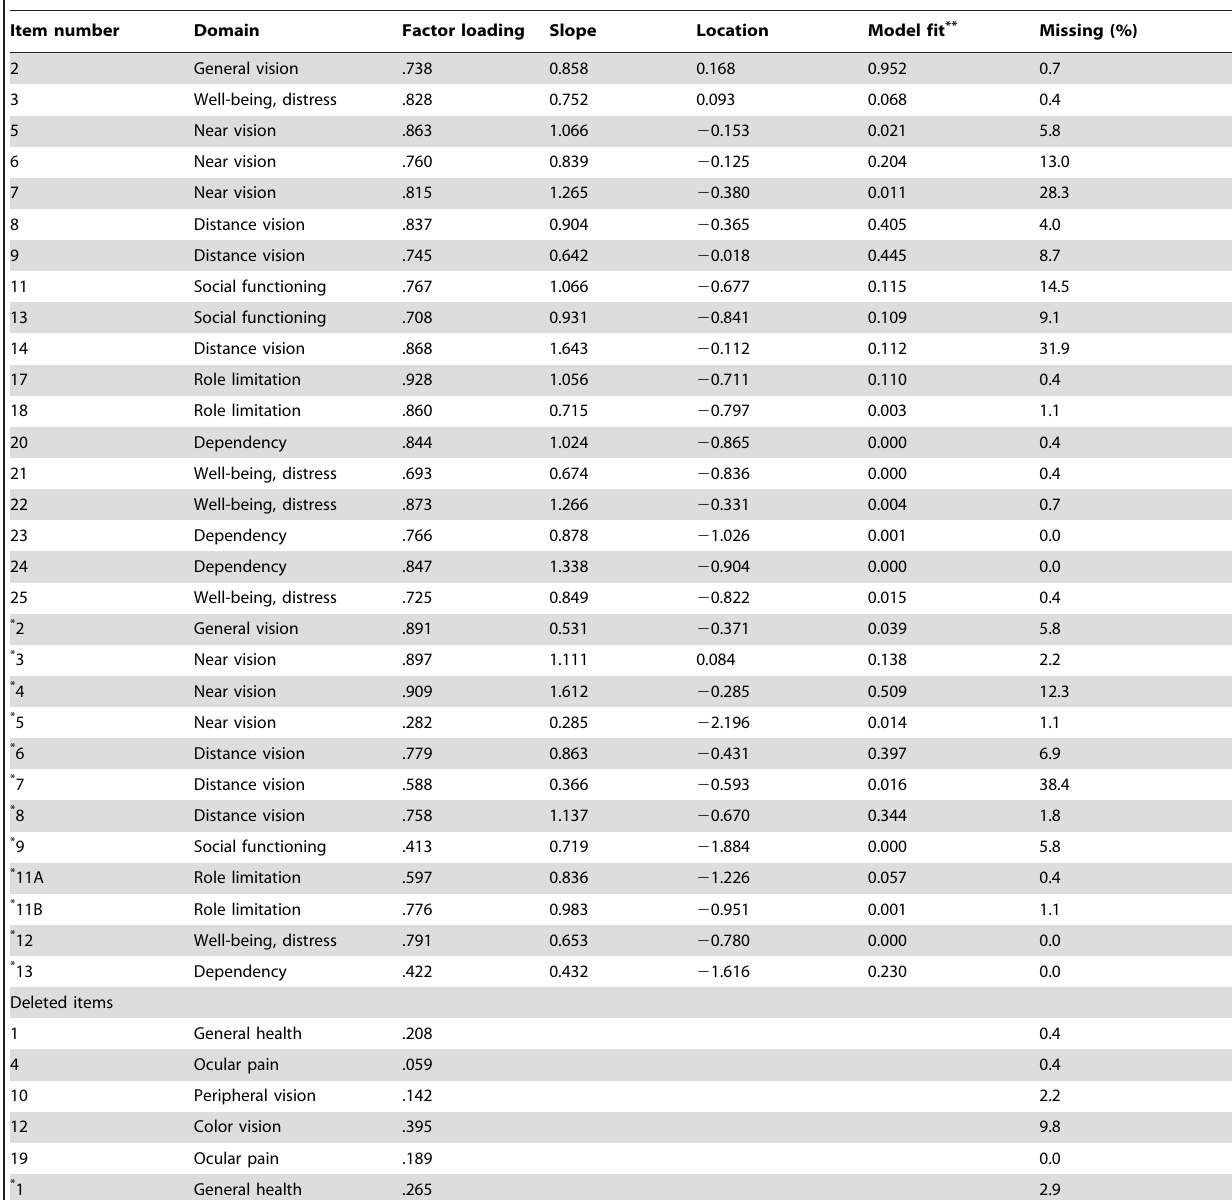
Table 1. Estimates of item